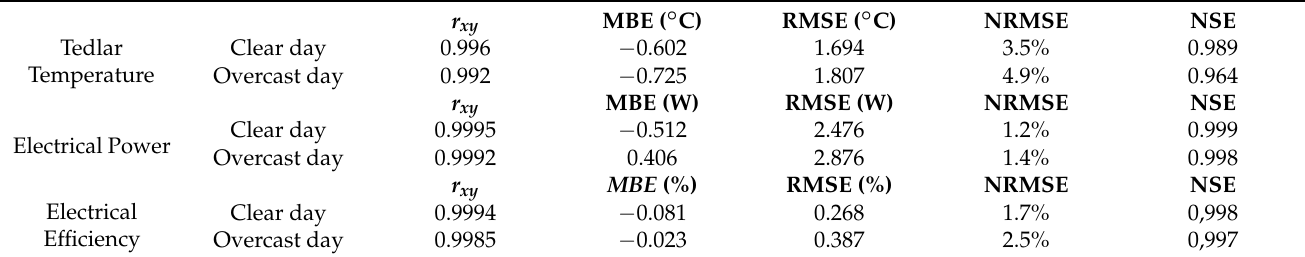
Table 2. Experimental validation indices for winter conditions.